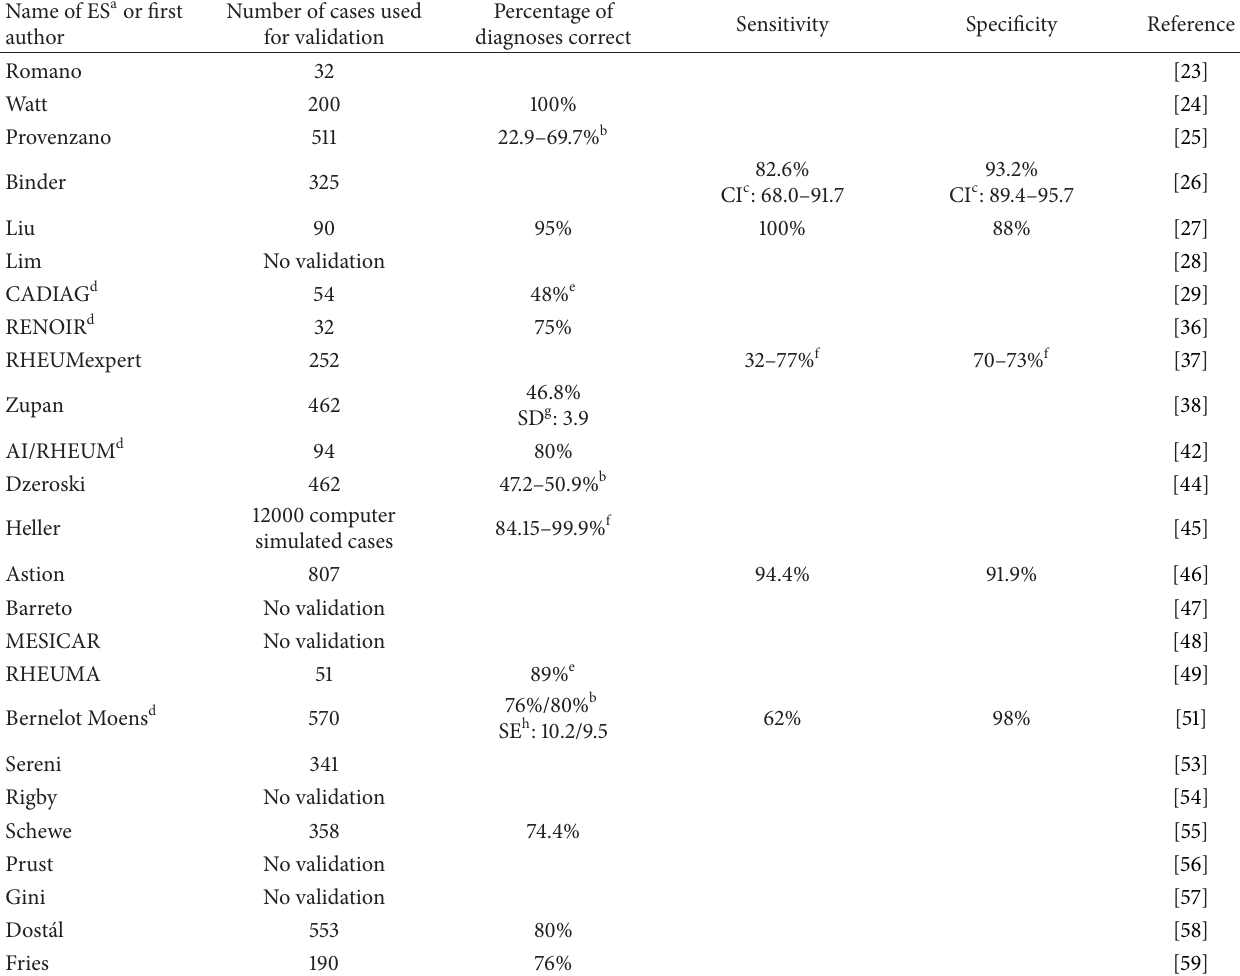
Table 2: Validation of the identified expert